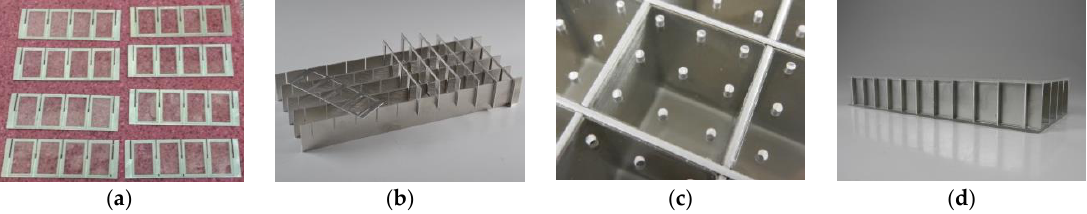
Figure 6. Manufacturing of acoustic liner samples: ( a ) adhesive bonding of films; ( b ) assembling of support structure; ( c ) attachment of face sheet; ( d ) acoustic liner sample.